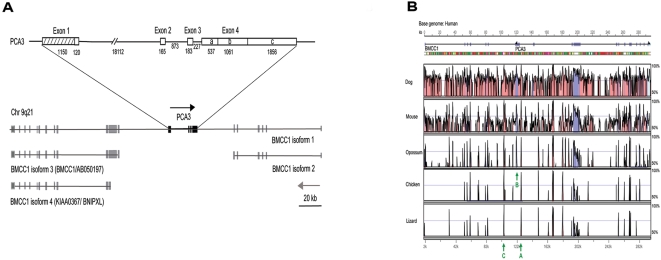

PCA3 is embedded within BMCC1.(A) The PCA3 gene (above) is embedded within the intron 6 of BMCC1 (PRUNE2) isoform 1 (BMCC1-1). Gray boxes denote exons of BMCC1 and black boxes denote exons of PCA3. The two genes are in the opposite orientation (NCBI Build 36). Three other isoforms of BMCC1 have also been described, none of which include the complete set of exons present in BMCC1-1. (B) VISTA plot of BMCC1 gene. Peak heights indicate degree of conservation between species of exons (blue) and evolutionary conserved regions (ECR within introns - pink) compared with human. Note that gene orientation is different in Fig 2A, upper and lower panels. We estimated the mutation rate at the DNA sequence level by comparing human and chimpanzee sequences and using a divergence time of 6 million years (Myr). The mutation rate in the PCA3 gene was estimated to be 1.26×10−9 per nucleotide per year, higher than that (1.00×10−9 per nucleotide per year) in the non-PCA3 portion of the BMCC1 gene, suggesting the PCA3 region might have a moderately higher mutation rate. Three highly conserved ECRs within BMCC1 are arrowed (A, B & C); Arrow ‘A’ (ECR_in1, 277 bp) is an extremely conserved non-coding sequence with 91% similarity between human and opossum that is positioned within intron 1 of PCA3; Arrow ‘B’ (ECR_ex4c, 403 bp) an ECR positioned within PCA3 exon 4 which is conserved in all mammals and appears to have been the focal point for the linear evolution of the PCA3 gene (see Fig. 3); Arrow ‘C’ (361 bp) is the most highly conserved ECR (a conserved non-coding sequence with 99% similarity between human and opossum) within BMCC1 (intron 6) immediately downstream of PCA3.